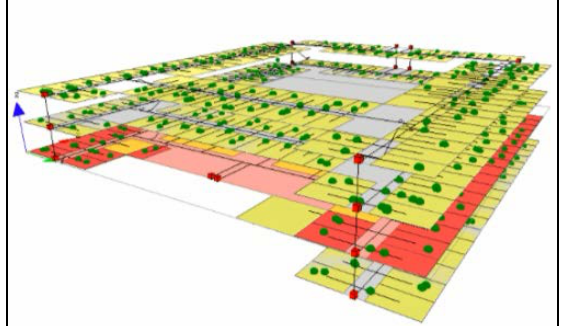
Figure 7. Evacuation simulation run in GAMA